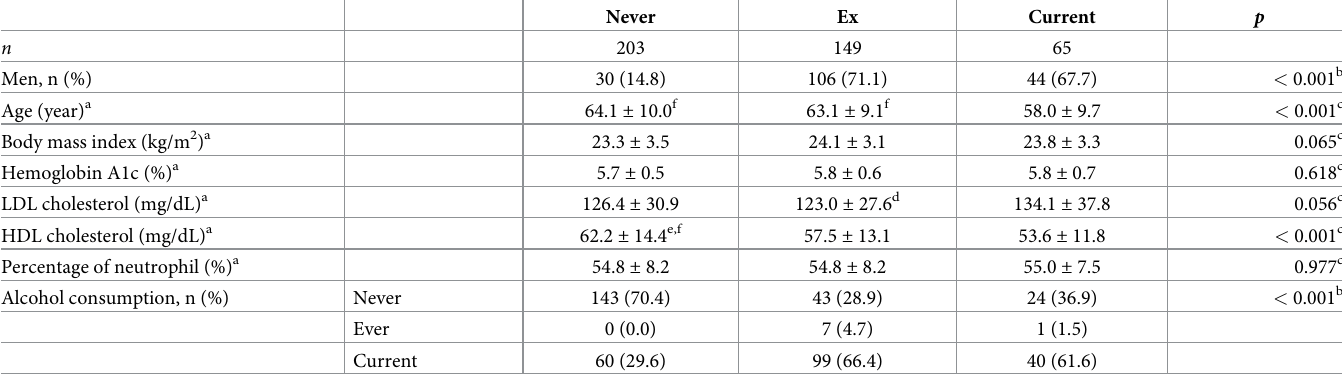
Table 1. Characteristics of the study subjects according to smoking